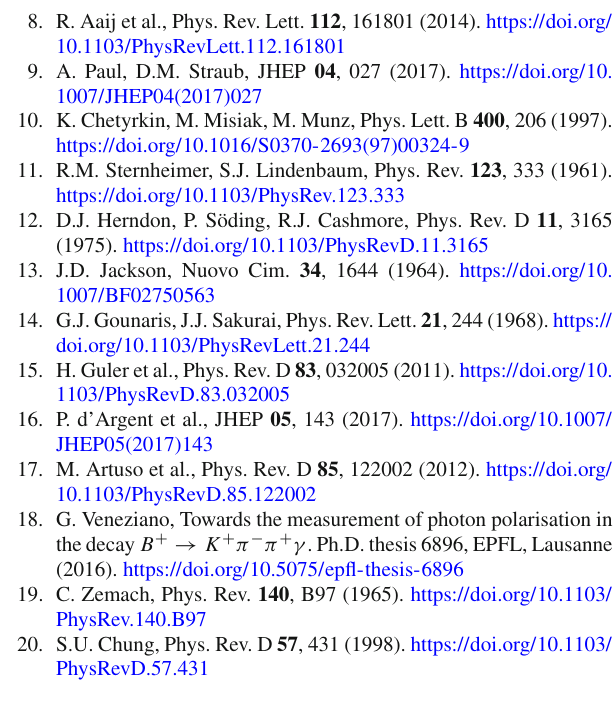
Table 9 Results of unbinned maximum likelihood fits for 100 pseudo- eters a and φ stand respectively for the relative magnitude and phase experiments, simulated according to the simplified two-amplitude between the decay with K 1 ( 1270 ) + → K + ρ( 770 ) 0 and the decay with K 1 ( 1270 ) + → K ∗ ( 892 ) 0 π + model with relative magnitude and phase ( 2 . 02 , 0 . 82 ) corresponding to a ratio of fractions of 2 . 47, and various values of λ γ . The param- Parameter True value Mean value Std deviation μ pull σ pull a 2 . 02 2 . 020 0 . 04 0 . 01 ± 0 . 11 1 . 14 ± 0 . 07 φ 0 . 82 0 . 823 0 . 02 − 0 . 09 ± 0 . 09 0 . 94 ± 0 . 07 λ γ 1 1 . 001 0 . 04 − 0 . 09 ± 0 . 12 1 . 17 ± 0 . 08 a 2 . 02 2 . 023 0 . 04 − 0 . 06 ± 0 . 11 1 . 17 ± 0 . 07 φ 0 . 82 0 . 823 0 . 03 − 0 . 13 ± 0 . 09 0 . 97 ± 0 . 06 λ γ 0 . 875 0 . 870 0 . 04 0 . 11 ± 0 . 11 1 . 17 ± 0 . 08 2 . 02 − 0 . 03 ± 0 . 09 1 . 03 ± 0 . 07 0 . 82 0 . 92 ± 0 . 06 0 . 75 0 . 04 0 . 20 ± 0 . 09 1 . 03 ± 0 . 07